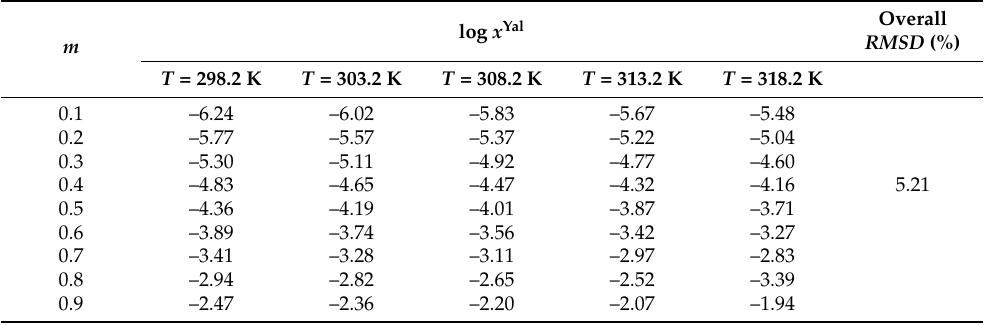
Table 8 documents the outcomes of the correlation with the “Yalkowsky-Roseman model”. The overall RMSD for this model was calculated to be 5.21%, demonstrating a strong correlation of FXT (3) solubility data in various {PEG 400 (1) + H 2 O (2)} combinations using the “Yalkowsky-Roseman model”. Table 8. Results for Yalkowsky–Roseman model for FXT (3) in several {PEG 400 (1) + H 2 O (2)} combinations at 298.2–318.2